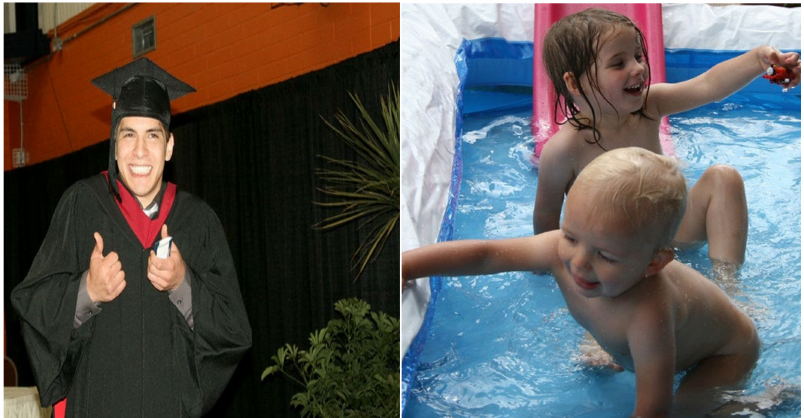
Figure 6. Example of positive sentiment images from the dataset.